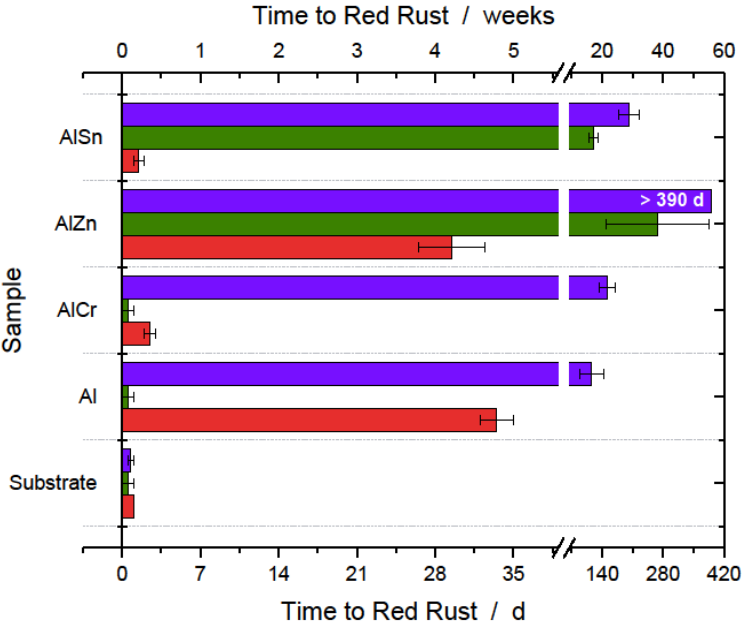
Figure 8. Time to red rust in neutral salt spray test ( ■ , red) and environmental exposure test (scratch: ■ , green; whole surface: ■ , purple) for uncoated steel substrates and steel coated with Al, AlCr, AlZn, and AlSn. The values for the environmental exposure represent the time to a red rust coverage of 5%.